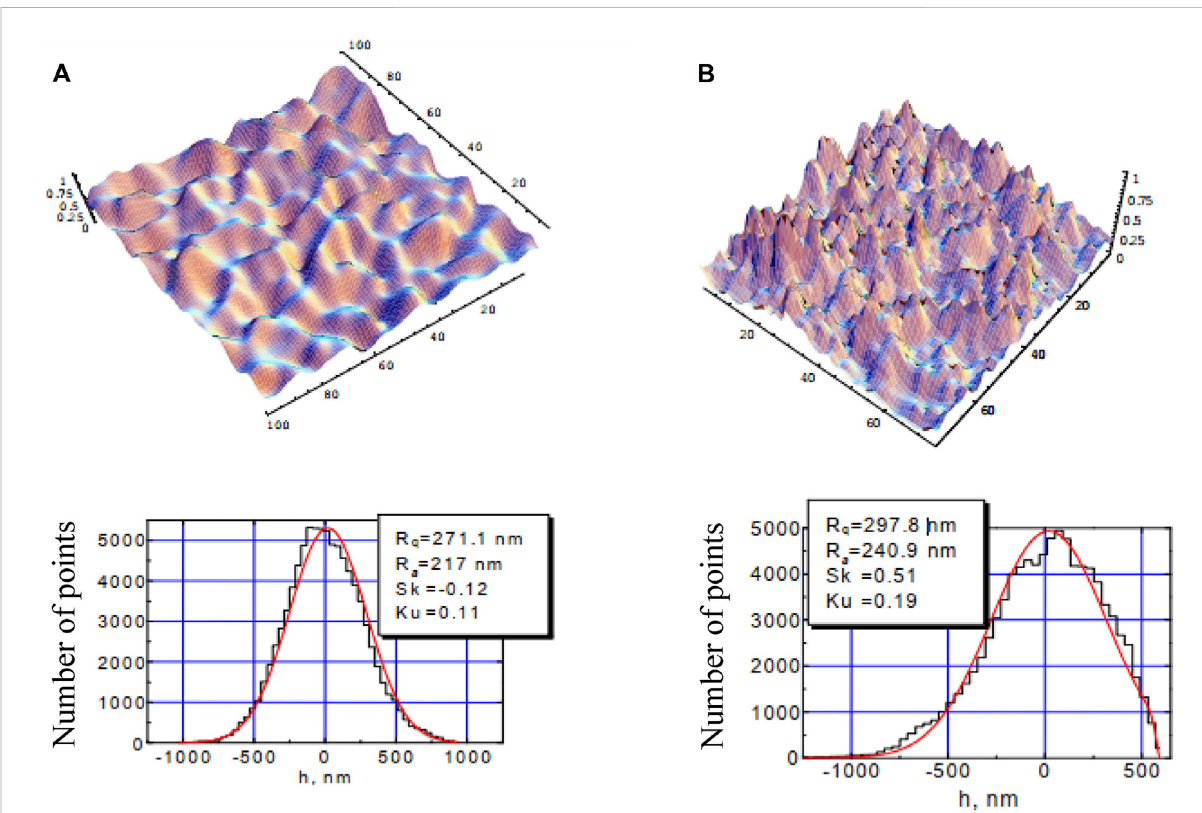
FIGURE 7 Relief, height distribution function and statistical parameters of (A) random non-fractal and (B) fractal surfaces. Sizes in the upper-row images are indicated in